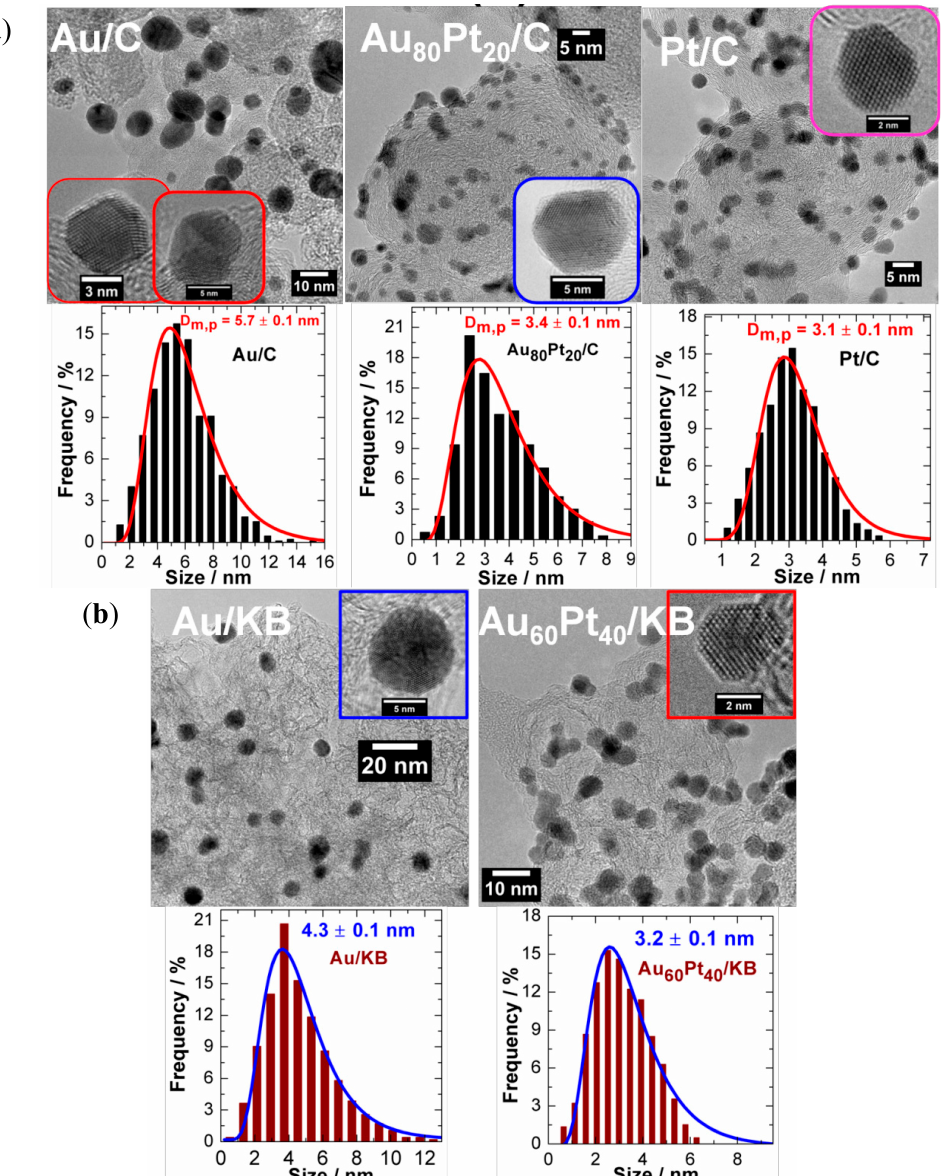
Figure 8. TEM-HRTEM micrographs and their corresponding particle size distribution (histograms were fitted using the log-normal function) of the nanostructured AuPt (20 wt%) supported on ( a ) Vulcan XC 72R and ( b ) Ketjenblack EC-600JD. (a) Reprinted and adapted with permission from Ref. [103]. Copyright 2014, John Wiley & Sons, Inc. ( b ) Reprinted and adapted with permission from Ref. [102]. Copyright 2014, John Wiley & Sons,